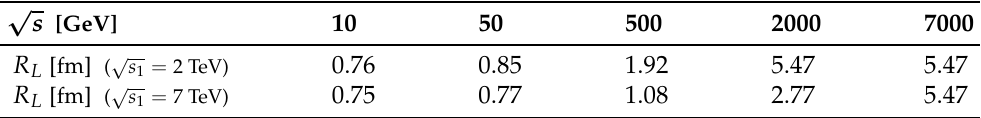
Table 3. The longitudinal radius R L of the